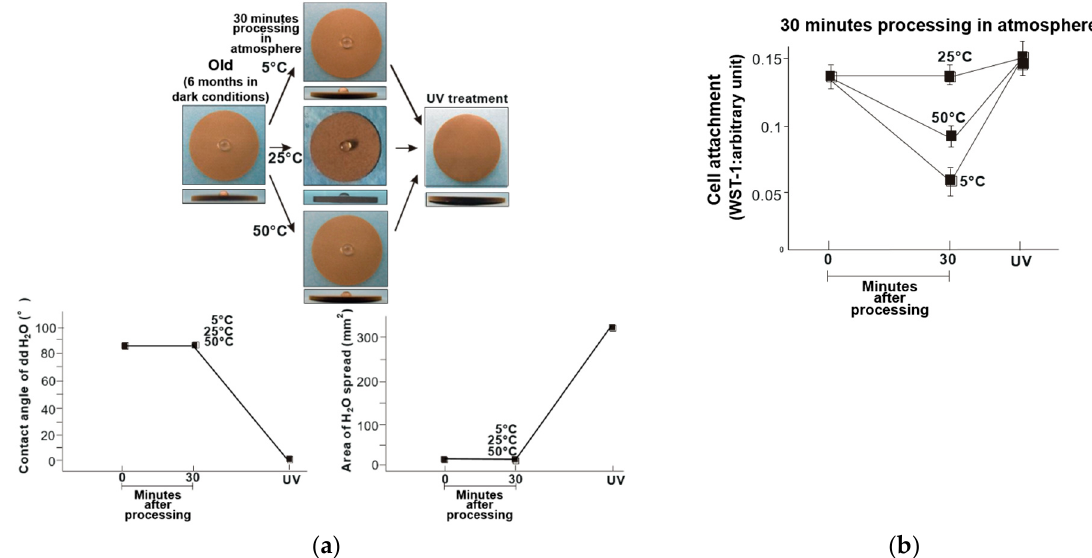
Figure 7. ( a ) Hydrophobicity/hydrophilicity of the UV-treated old–dry titanium disk surfaces illustrated as a photograph of 10 µL ddH 2 O placed on the sample surface before and after temperature deviation (upper middle) with the corresponding contact angle (lower left) and spread area (lower right). ( b ) Initial attachment of osteoblasts to the UV-treated old–dry titanium disk surfaces.